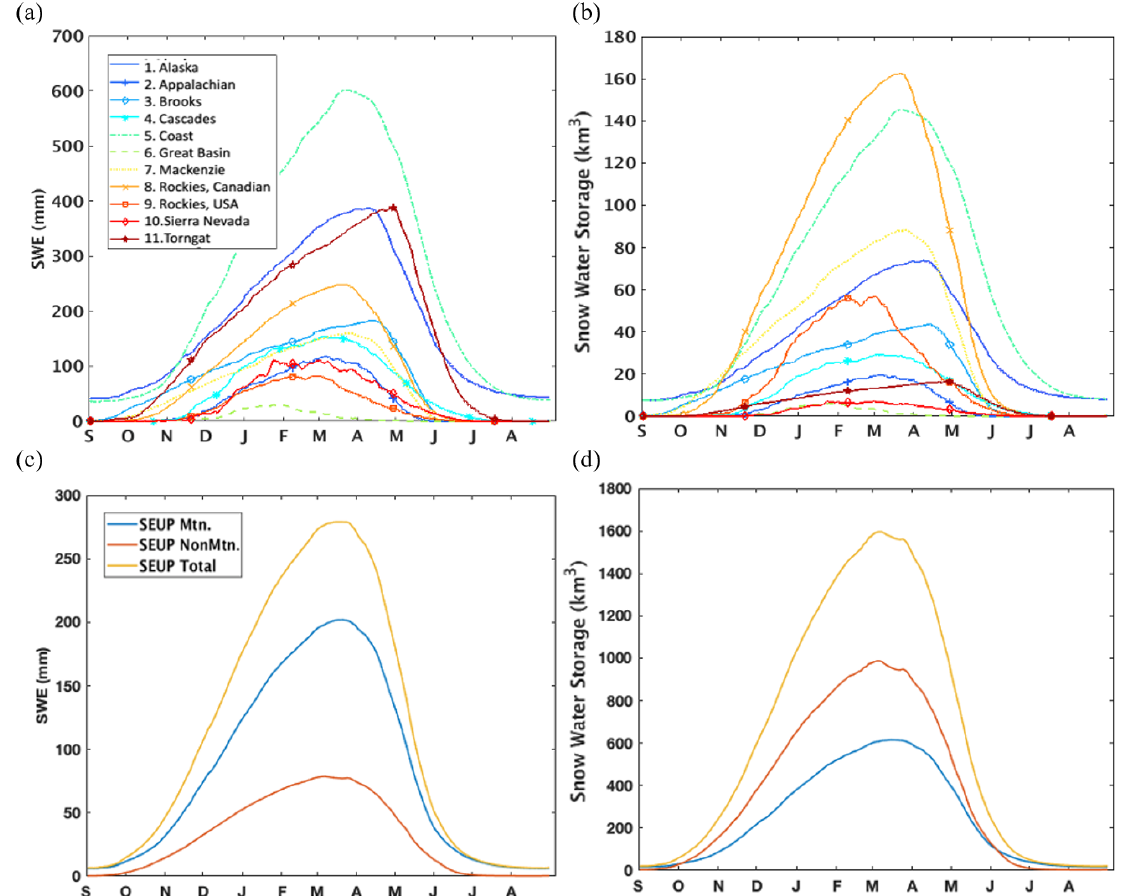
Figure 8. (a) Climatological SWE (in millimeters) within each mountain range, computed from domain ensemble mean SWE over a water year. (b) Total snow water storage (SWS; in cubic kilometers) climatology within each mountain range, computed from domain ensemble mean SWS over a water year. The mean seasonal cycle of domain-averaged SWE (c) and SWS (d) for mountain areas, non-mountain areas, and North